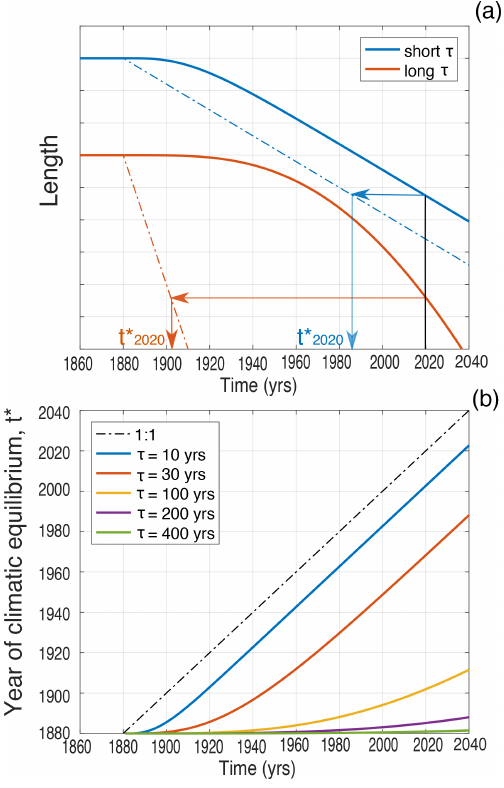
Figure 10. (a) Illustration of the concept of t ∗ for a linear temper- ature trend starting in 1880. The thicker lines show the evolving glacier length as a function of time, for small- τ (blue) and large- τ (orange) glaciers. Dash-dotted lines show the glacier length that would be in equilibrium with the evolving climate as a function of time. For any given year, t ∗ is found from the separation in time between these two lines. (b) Time of climatic equilibrium, t ∗ , for the length of a glacier subjected to a linear warming trend, shown as a function of time and response time τ . Large- τ glaciers are far out of equilibrium from the modern climate (Christian et al., 2018). Curves calculated from Eq.